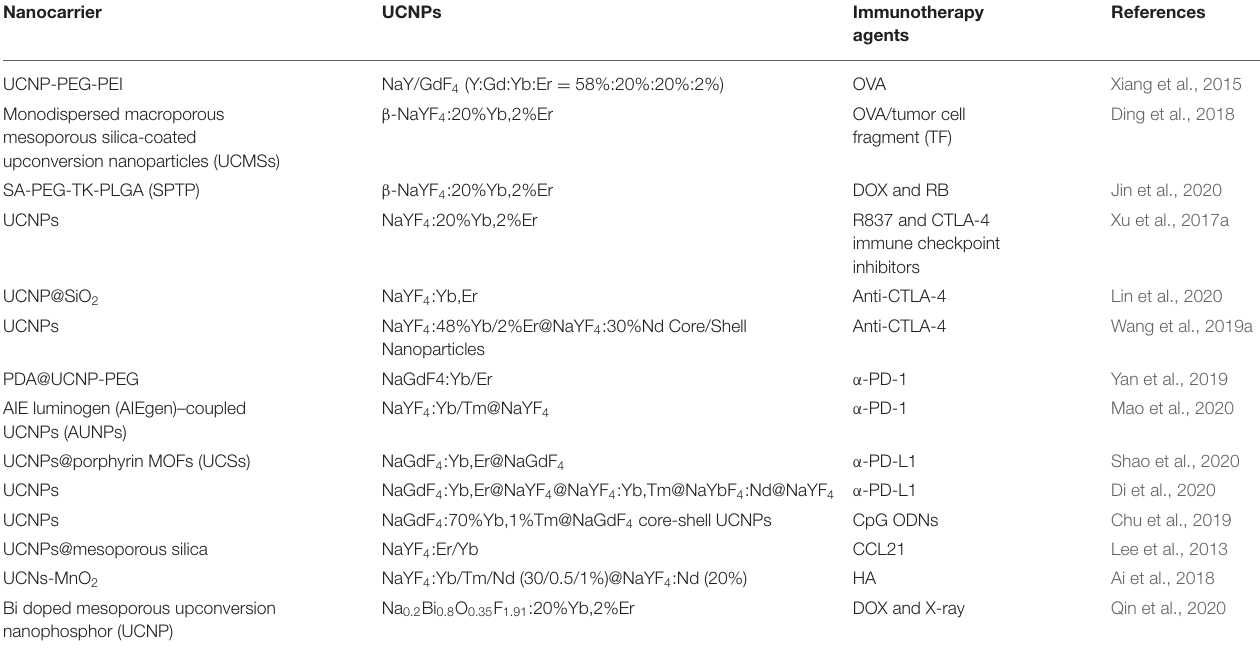
TABLE 1 | Summary of UCNPs combined with